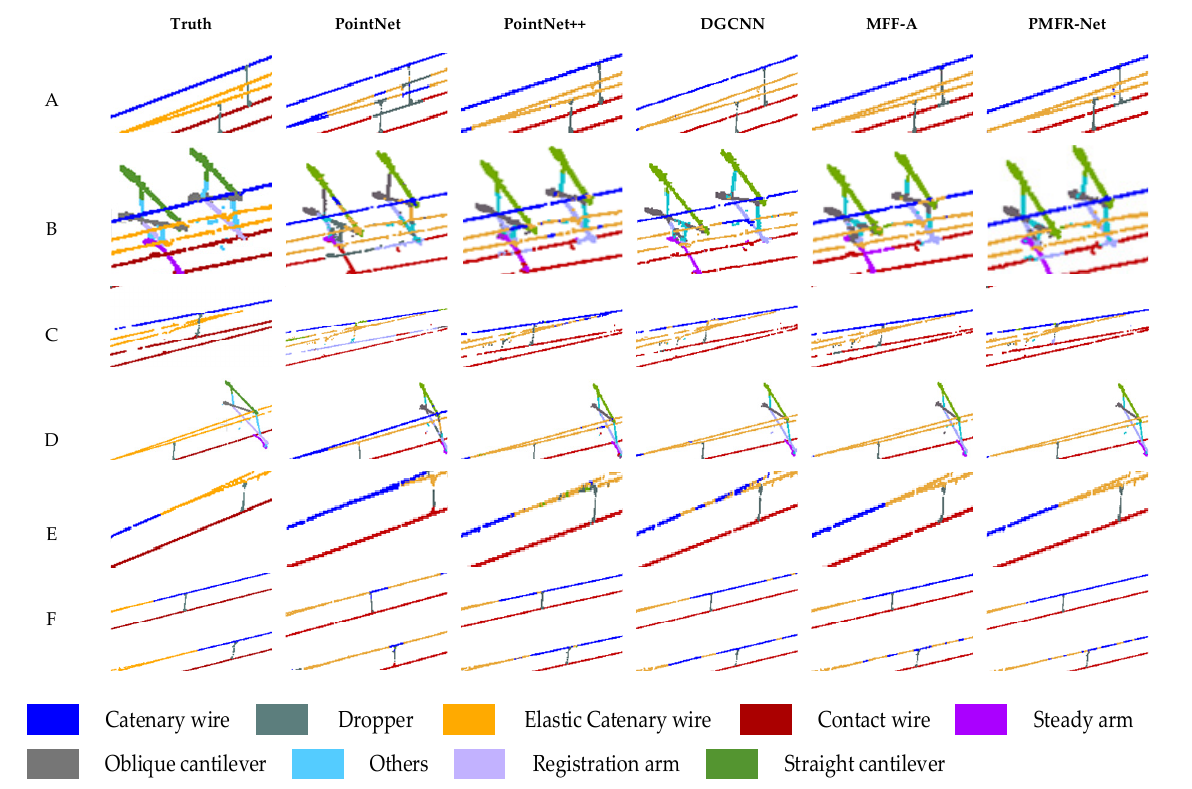
Figure 9. Semantic segmentation results of the OCS point cloud are based on different methods. The range delineated in the red box is enlarged to present a more detailed visual comparison at the bottom, where A, B, and C are the ROI in the double-arm scene, and D, E, and F are the ROI in the single-arm scene. Table 5. Quantitative evaluation (%) of comparative methods on the S3DIS point cloud dataset. The best metric is highlighted in